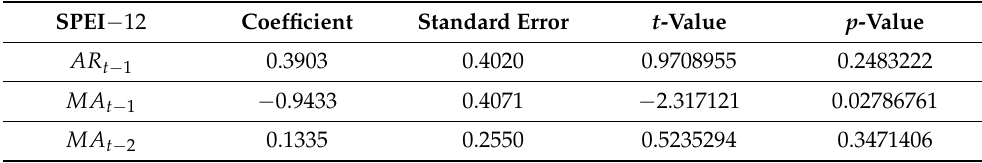
Table 12. SPEI-12 ARIMA (0,1,0)(1,0,2) for Seasonal.